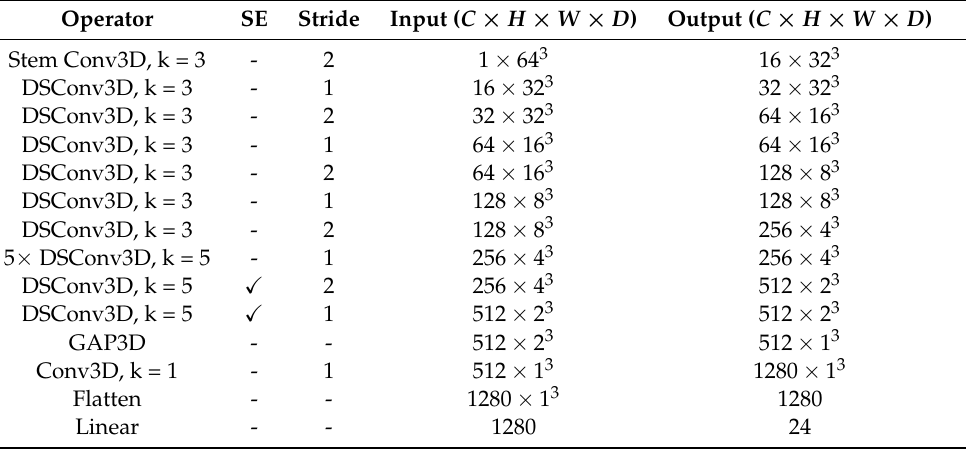
Table 1. Configuration details of FeatureNetLite; k = 3 denotes that convolution kernel size is set to 3, and SE denotes whether to use the Squeeze-and-Excite module. And if SE is set to (cid:88) , it means Squeeze-and-Excite module is